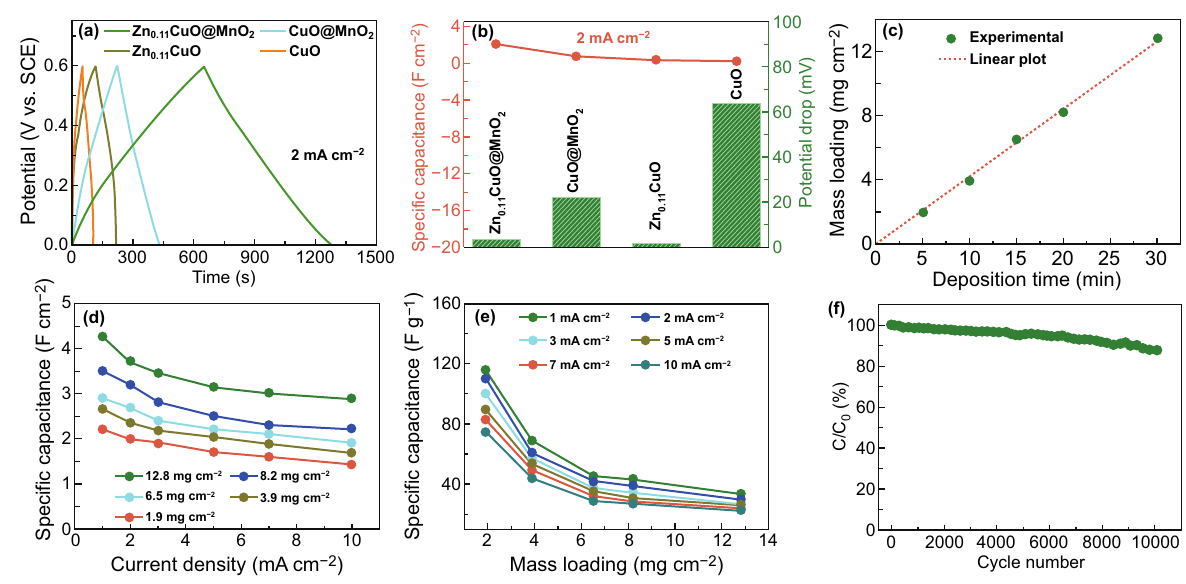
Fig. 4 a Comparison of GCD curves of typical CuO, CuO@MnO 2 , Zn 0.11 CuO and Zn 0.11 CuO@MnO 2 electrodes at a current density of 2 mA cm −2 . b Areal capacitances and potential drops of obtained from CuO, CuO@MnO 2 , Zn 0.11 CuO, and Zn 0.11 CuO@MnO 2 electrodes. c Relationship between the mass loading of MnO 2 and the electrodeposition time. d, e Areal capacitances and gravimetric capacitances of Zn 0.11 CuO@MnO 2 electrodes with different amount of MnO 2 at different current densities. f Capacitance retention plotted versus cycle